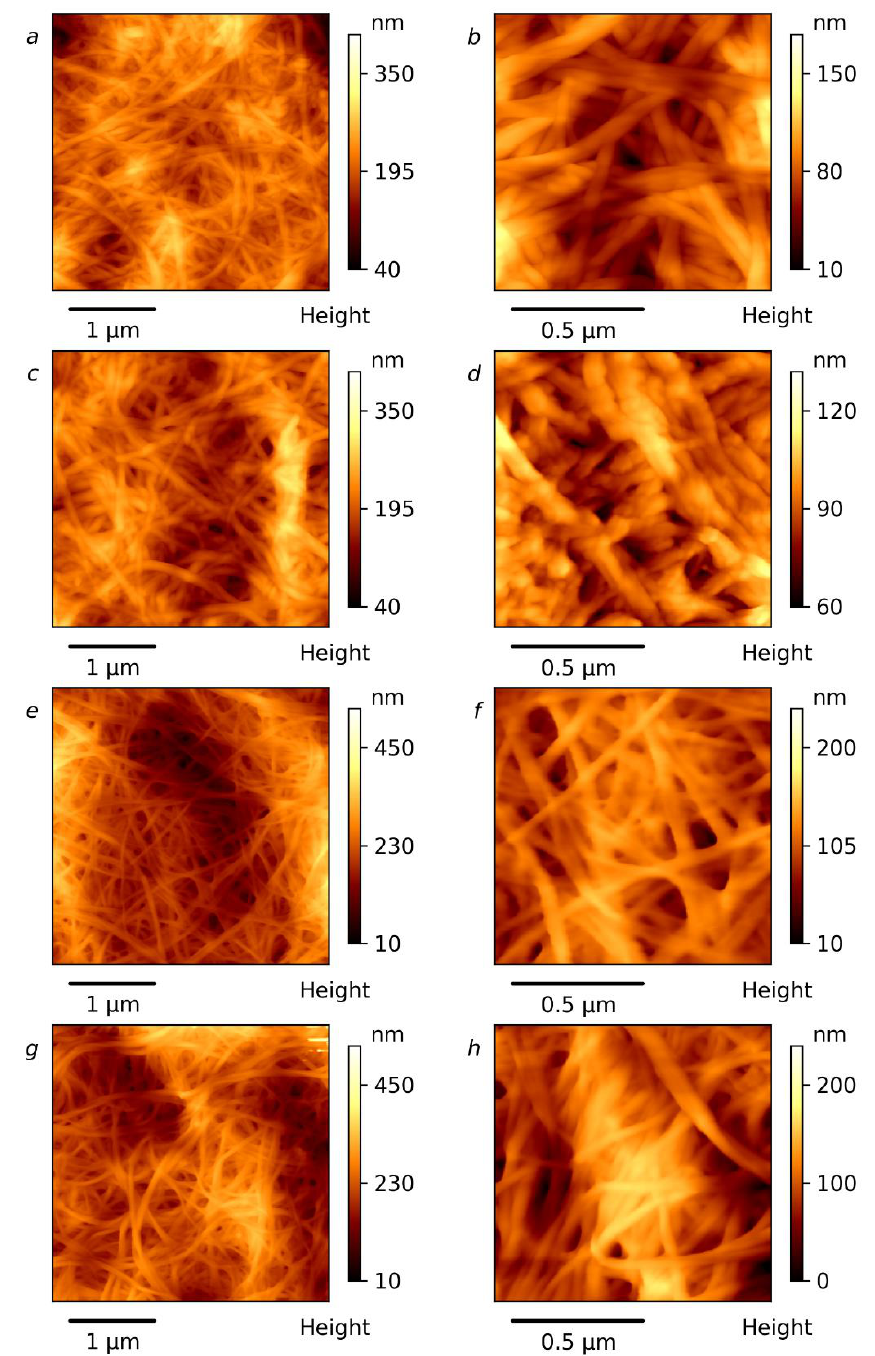
Figure 6. AFM images of surface topography of BC-NFs: E − ( a , b ), E+ ( c , d ), G − ( e , f ) and G+ ( g , h ). To obtain more insights into the prepared BC-NF film structures, SEM images of the films’ surfaces were acquired (Figure 7). As shown in Figure 7, the surfaces of all of the films had a compact cellulose network-like structure consisting of ultrafine nanofibers resembling randomly entangled ribbons. In addition, the SEM data demonstrate that all films are dense and there is no significant difference in fiber packing density. This data correlate with the BC-NF paper density data discussed earlier (see Table 1).